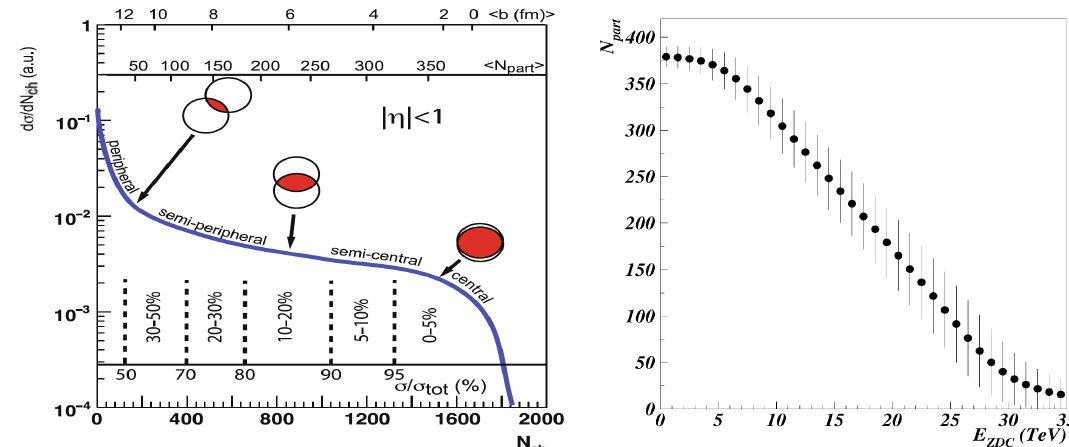
Figure 12. Left : A cartoon showing the centrality definition from the final-state charged particle multiplicity N ch and its correlation with the average impact parameter (cid:104) b (cid:105) and the mean number of nucleons participating in the collision < N part >. Reproduced from Ref. [27]; Right : The number of participants N part as a function E ZDC in Pb + Pb collision at incident momentum per nucleon 158 √ s GeV/ c ( = 17.3 GeV) calculated in the Glauber approach. Reproduced from Ref. [218]. The error NN bars represent the r.m.s. of the N part distribution at fixed E ZDC .